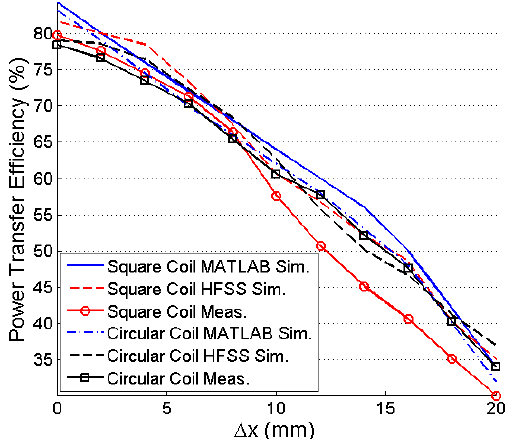
Figure 17. Efficiency versus lateral misalignment.